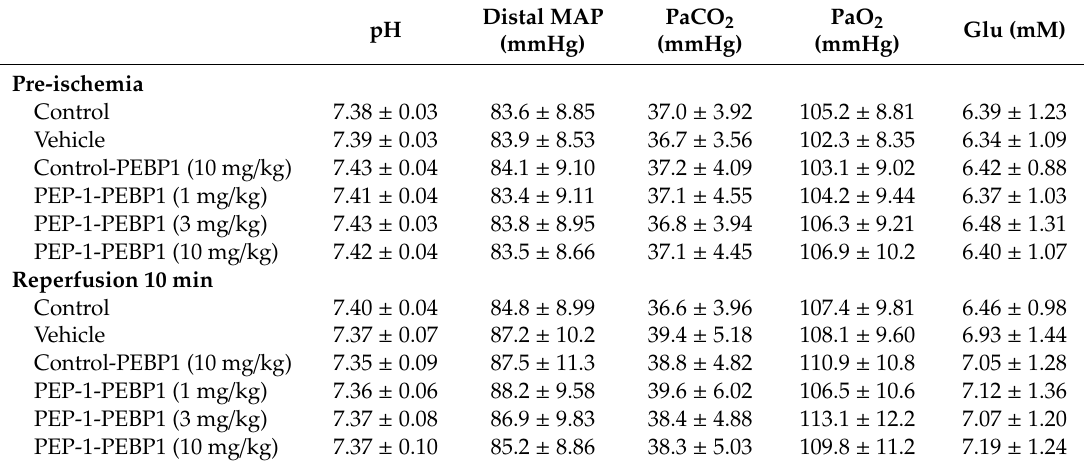
Table 1. Physiological parameters 10 min before and after ischemic